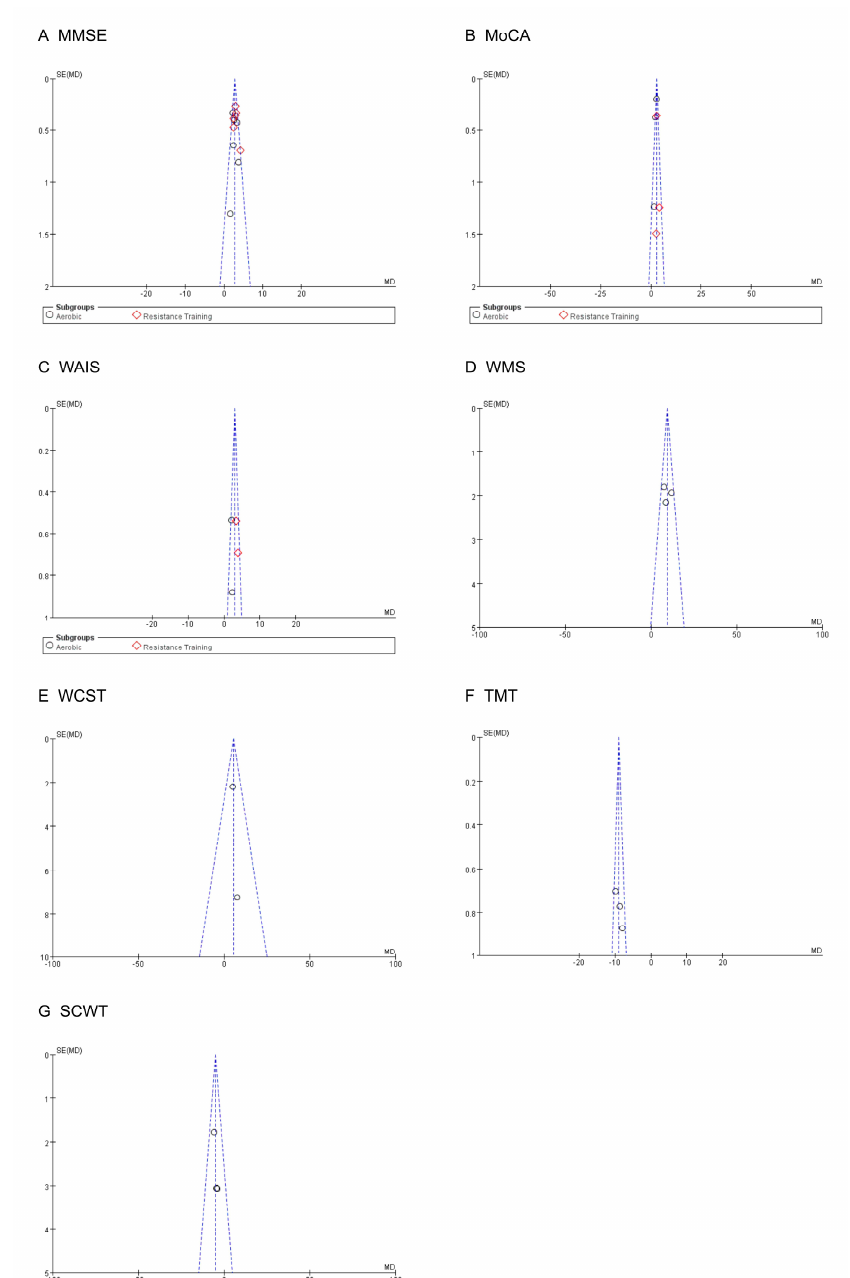
Figure 10. Funnel plot assessing the publication bias.